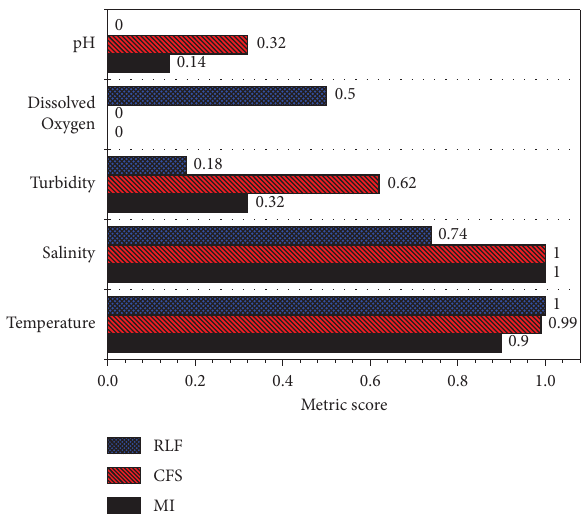
Figure 5: Infuence of water quality variables on harvest outcome, considering growth as the main metric.